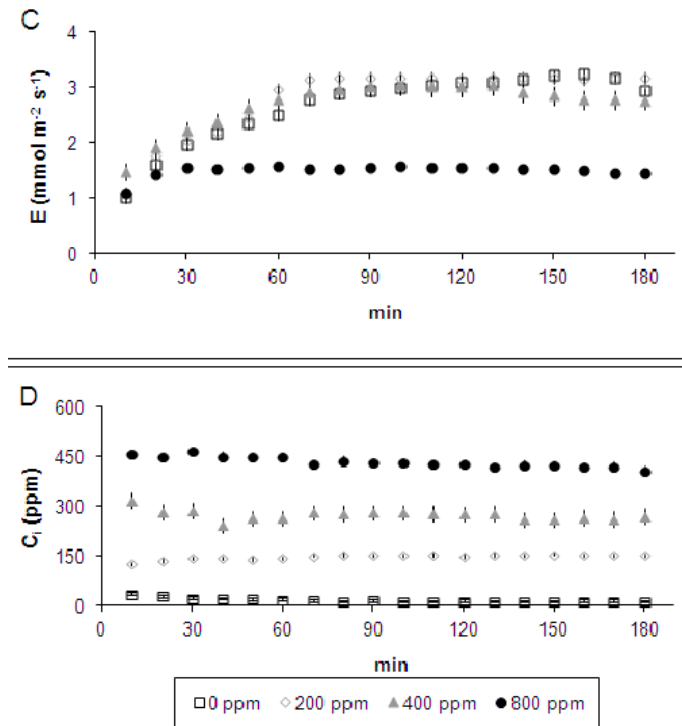
Figure 1. Time course (10 min step) of ( A ) leaf net photosynthesis (P n ); ( B ) leaf stomatal conductance (g s ); ( C ) transpiration rate (E); and ( D ) leaf substomatal CO 2 concentration (C i ), measured in Nicotiana tabacum leaves treated with air containing different CO 2 concentrations. Zero ppm CO 2 : black empty squares; 200 ppm CO 2 : grey empty diamonds; 400 ppm CO 2 : grey filled triangles; 800 ppm CO 2 : black filled circles. Data are means of five points recorded every two minutes. Data are the averages of three independent biological samples ( error bars denote SE) for each treatment and time ( n = 3).